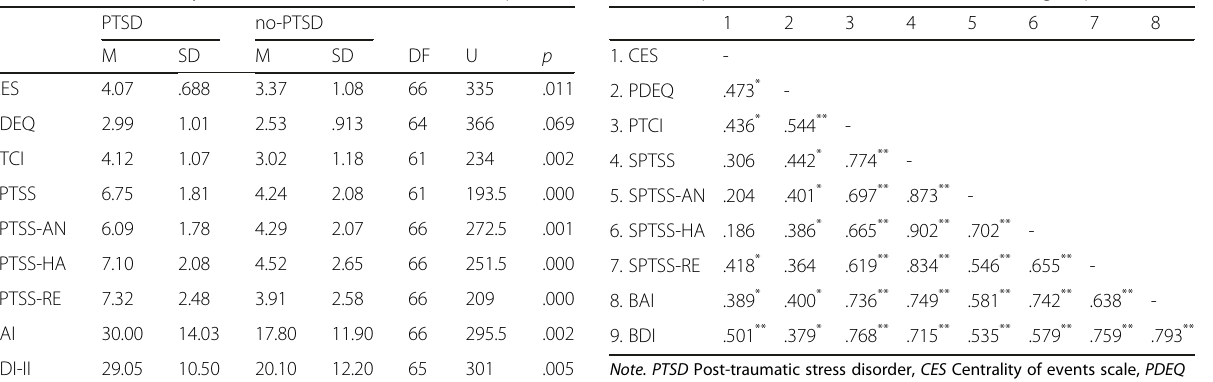
Table 1 Mann-Whitney Test for PTSD and no-PTSD Groups